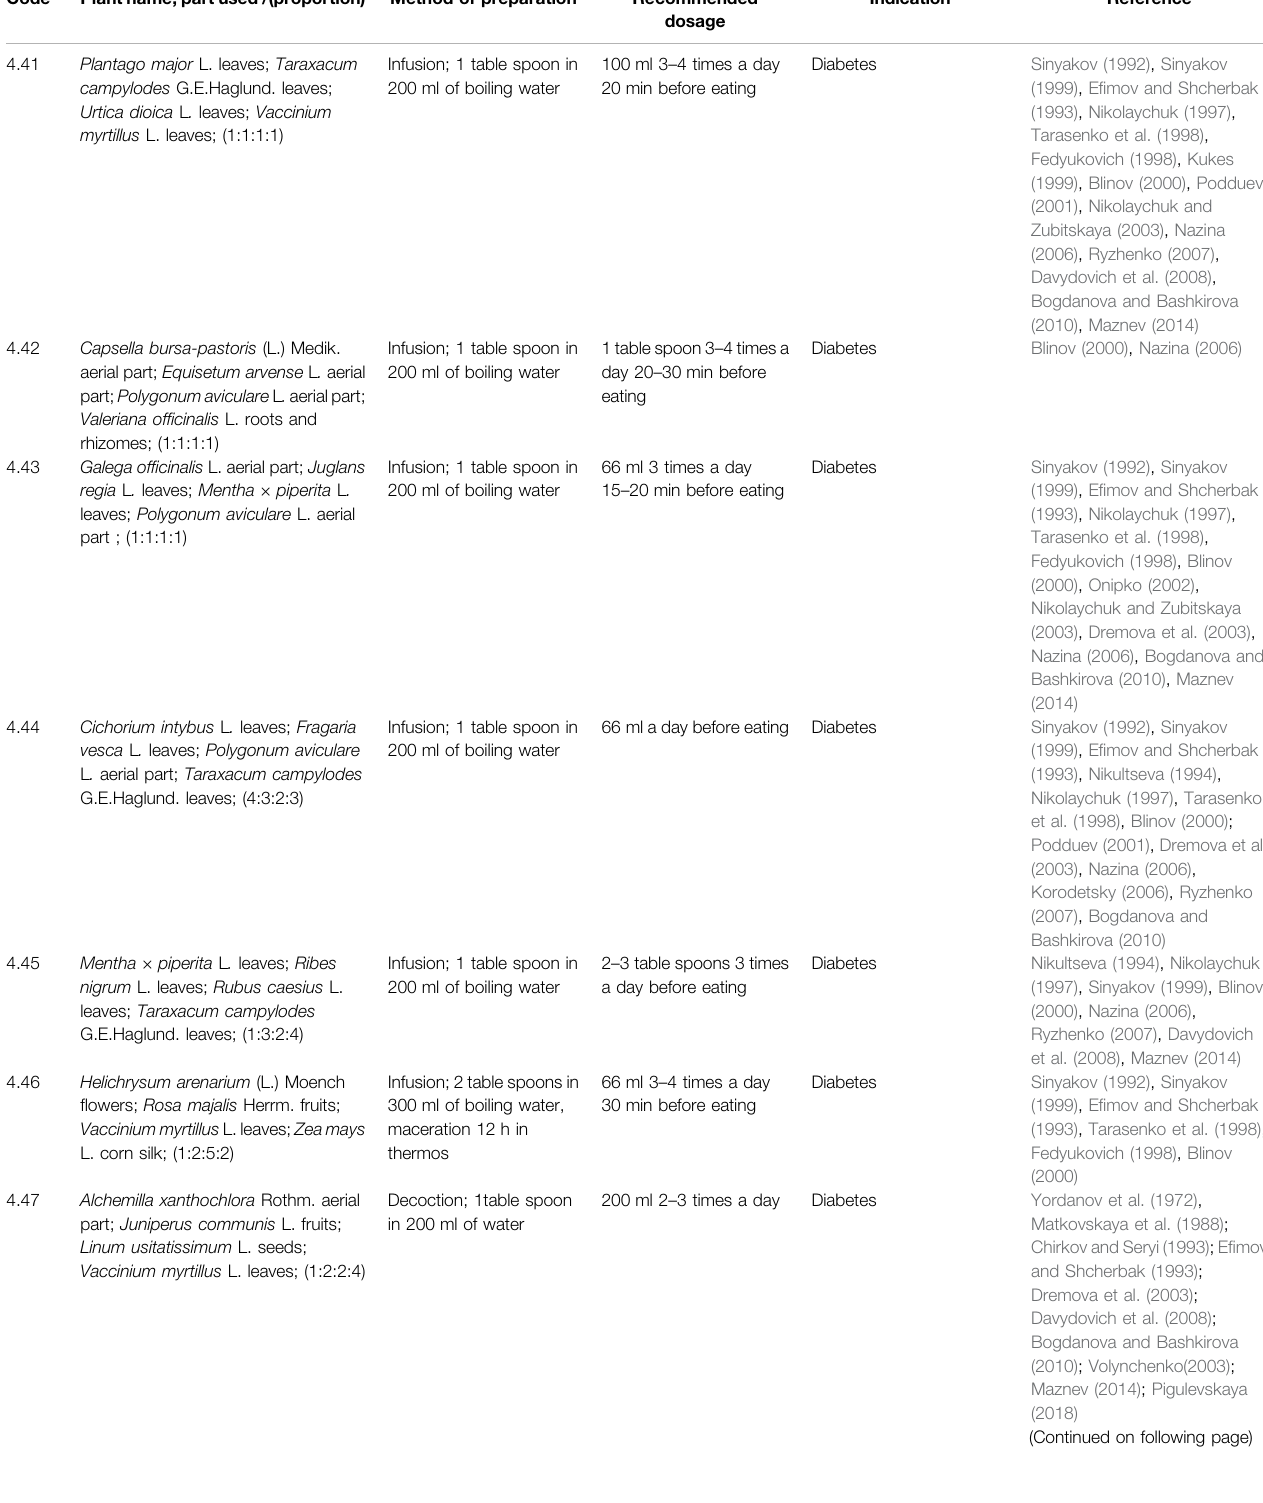
TABLE 1 | ( Continued ) The list of medical species used for the management of diabetes and related disorders in Russia. Code a Plant name, part used /(proportion) Method of